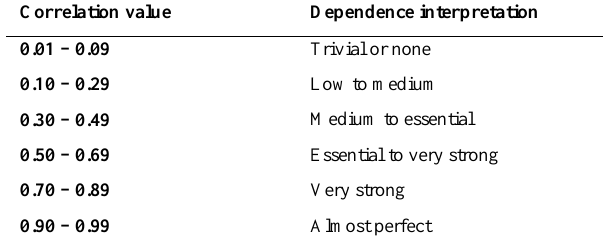
Table 1 . Interpretation of correlation coefficient values